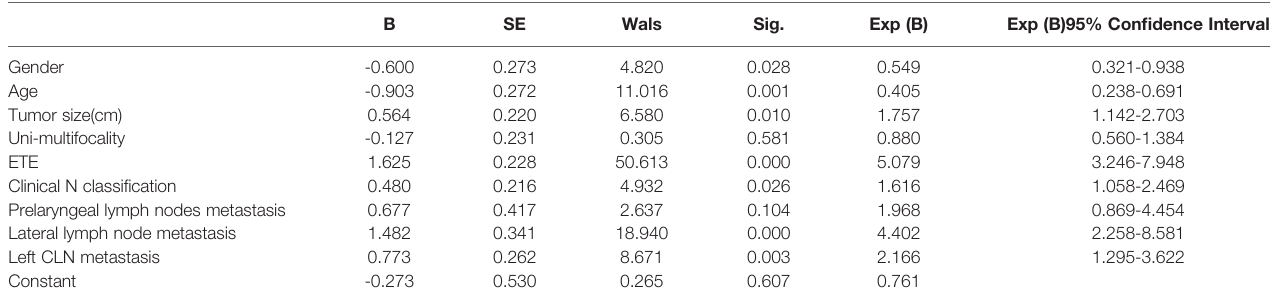
TABLE 4 | Multivariate Analysis of clinicopathologic characteristics in LN-arRLN lymph node metastasis.